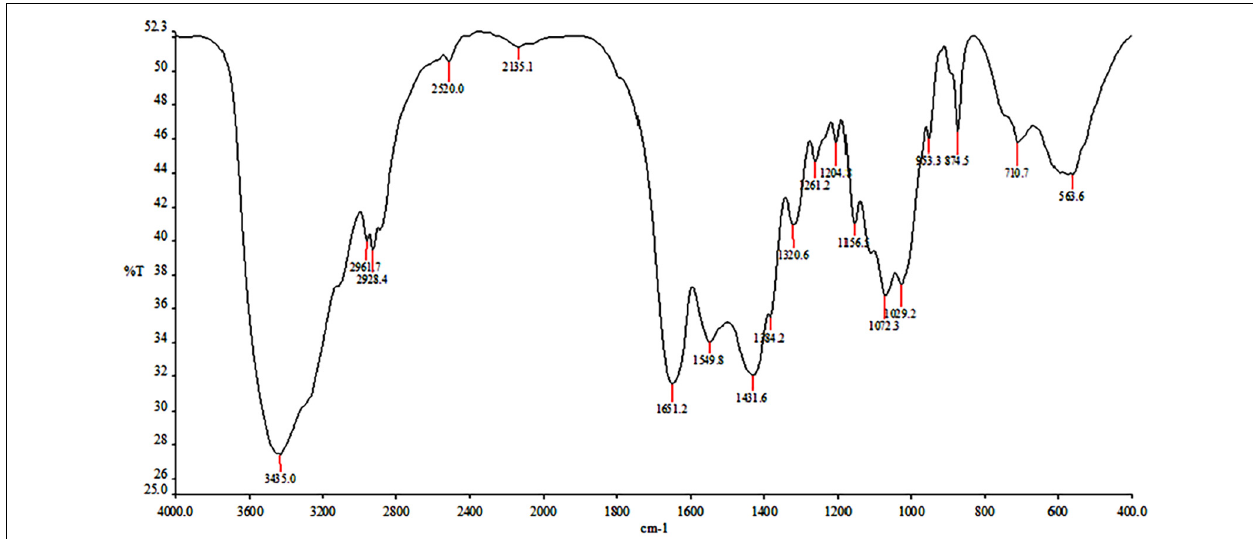
FIGURE 9 | FTIR spectrum of extracted shrimp shell chitin.